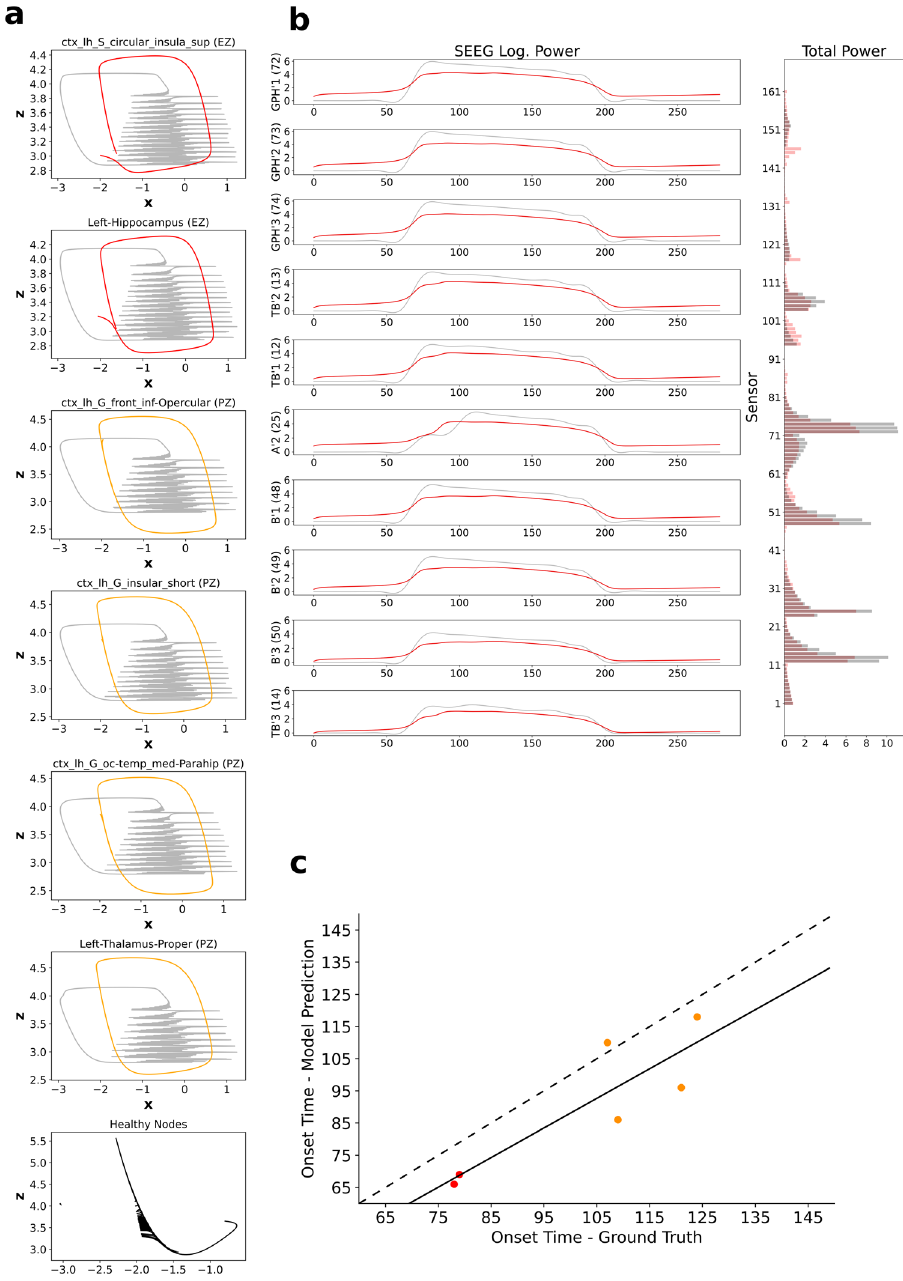
Fig. 2 Inferred seizure propagation pattern in synthetic data. a Phase plane plots of inferred 2D Epileptor source dynamics. For comparison with the ground truth, generated using 5D Epileptor, time series of local fi eld potential ( x 1 ( t ) + x 2 ( t )) and the corresponding permittivity variable z is shown in gray (see “ Synthetic data ” in “ Methods ” ). Inferred source dynamics of regions in EZ is shown in red, regions in PZ is shown in orange, and the remaining regions are shown in black. b Comparison of model-predicted SEEG log. Power (left) of ten sensors with highest power and the augmented data feature: total sensor power (right). Observations are shown in gray and model predictions are shown in red. c Seizure-onset times in ground truth vs. model predictions. Red dots represent the seizure-onset times of regions in EZ and orange dots represent the seizure-onset times of regions in PZ. Solid line represents the linear regression fi t and dashed line represents a perfect fi t. EZ, epileptogenic zone; PZ, propagation